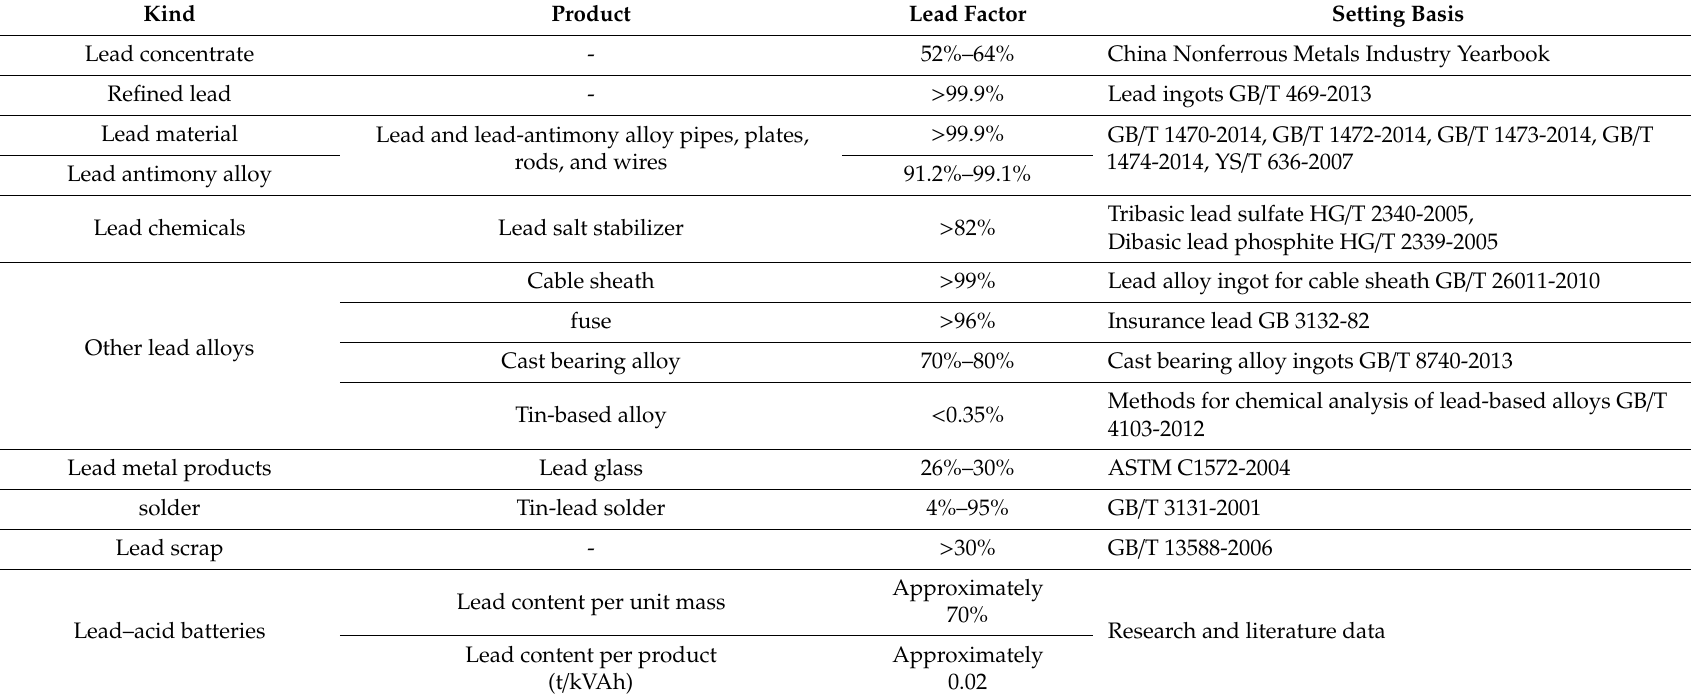
Table 1. Proportion of lead per unit